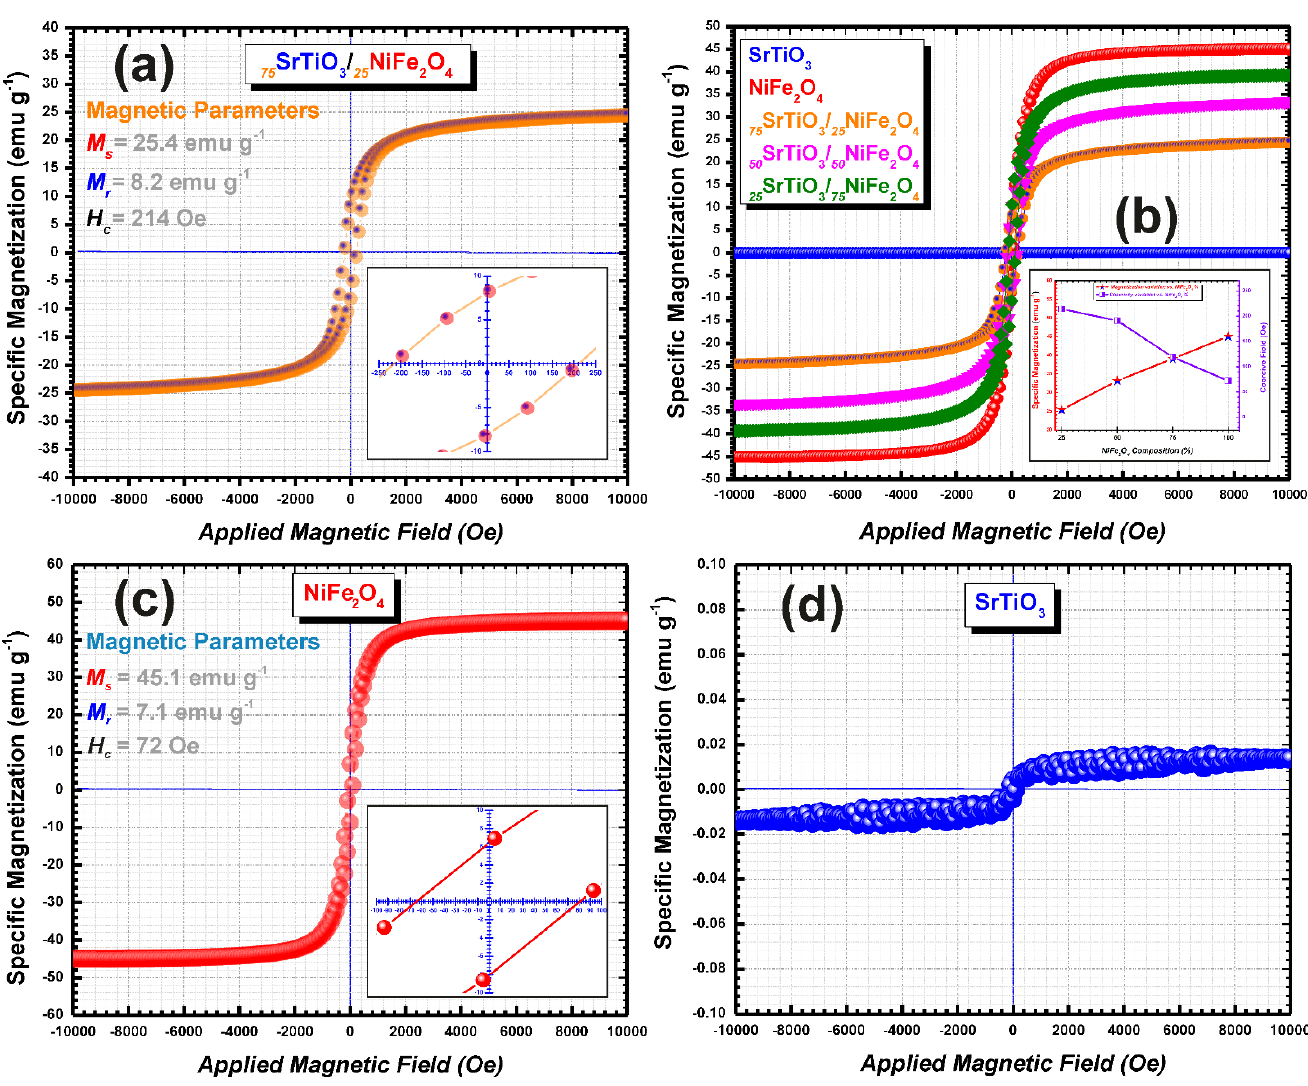
Figure 7. Room temperature hysteresis loops of the ( a ) 75 STO/ 25 NFO nanostructure, ( b ) all composites synthesized with different spinel phase percentage together with inset graph showing the magnetization and coercivity variation with spinel phase ratios, ( c ) pristine NiFe 2 O 4 nanoparticles with inset graph showing the loop at near-zero magnetic field, and ( d ) pristine SrTiO 3 nanoparticles.